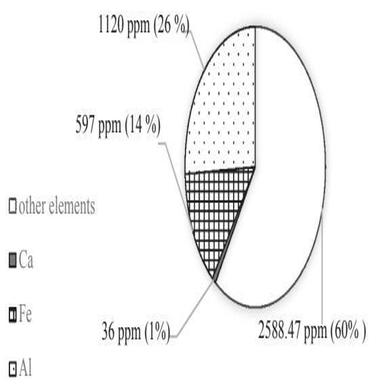
ICP plasma spectroscopy data concentrations of alkali metals in Limestone sample.